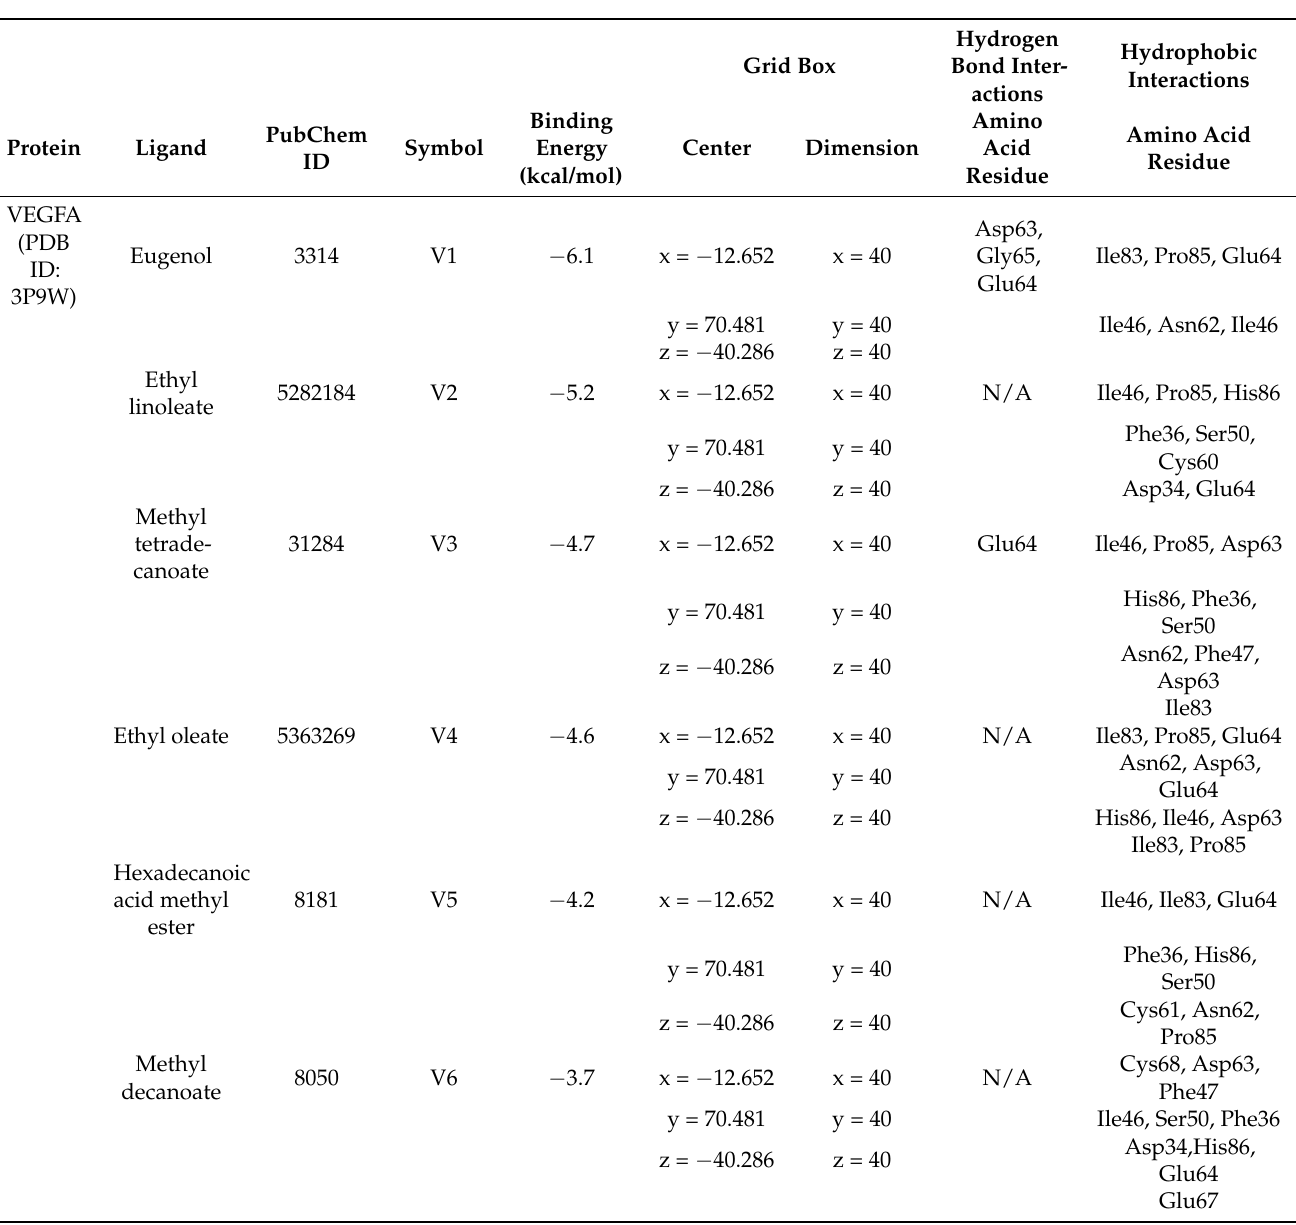
Table 7. Binding energy of potential active compounds on VEGFA (PDB ID: